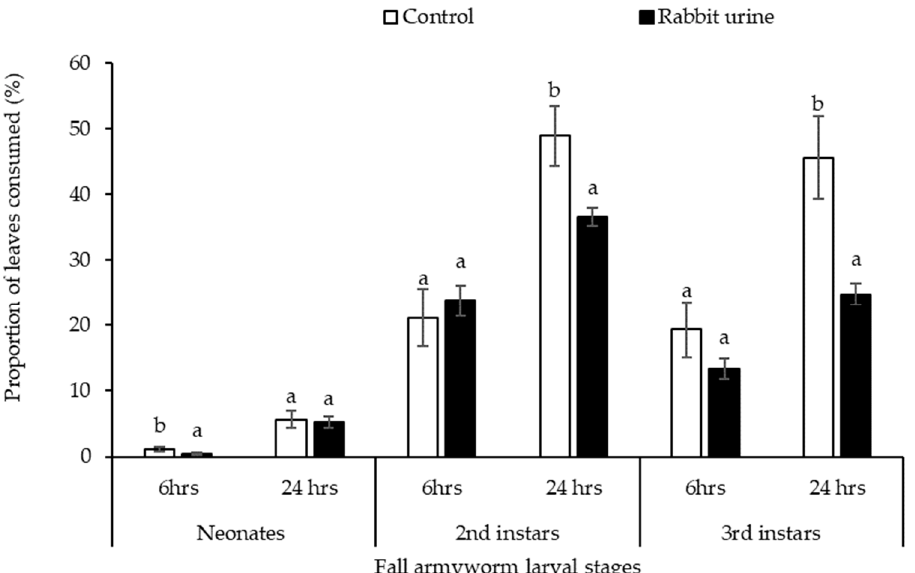
Figure 5. Proportion of leaf area consumed by fall armyworm (FAW) larval stages. The maize leaves were treated with rabbit urine (undiluted form) and distilled water (control) and were exposed to FAW larvae for 6 and 24 h. Error bars indicate standard errors. Different small letters in the columns indicate significant differences at p = 0.05 (Tukey test). Neonates are the first instar larval stage.